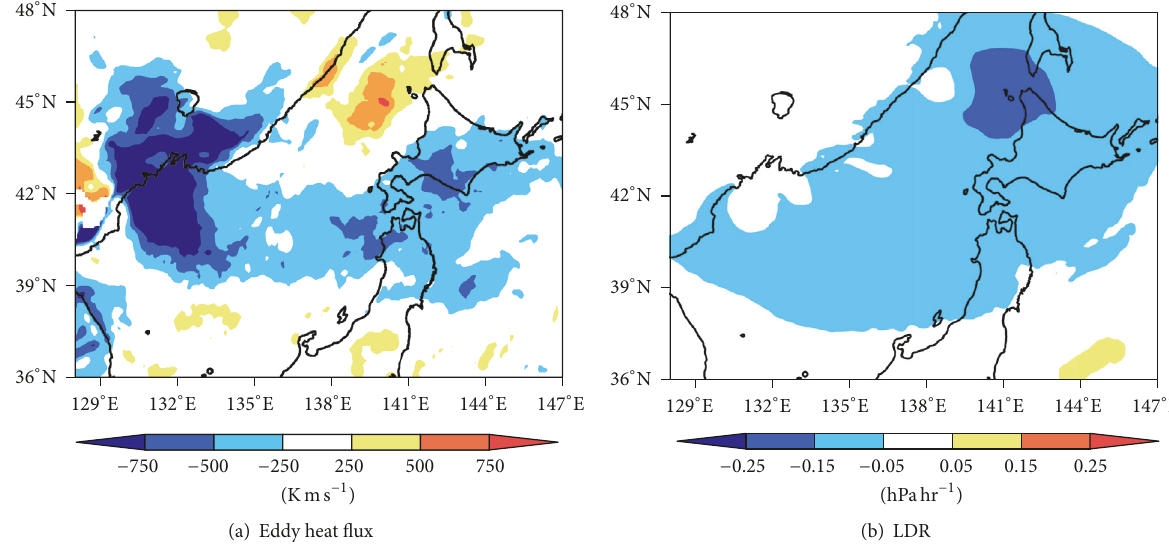
Figure 11: (a) Composite differences in the 850 hPa poleward eddy heat flux between the MOD and CTL runs (former minus latter) based on the three typical cases. The shading interval is 250 Kms −1 . (b) As in Figure 11(a) but for the local deepening rate (LDR). The shading interval is 0.1hPa hr −1